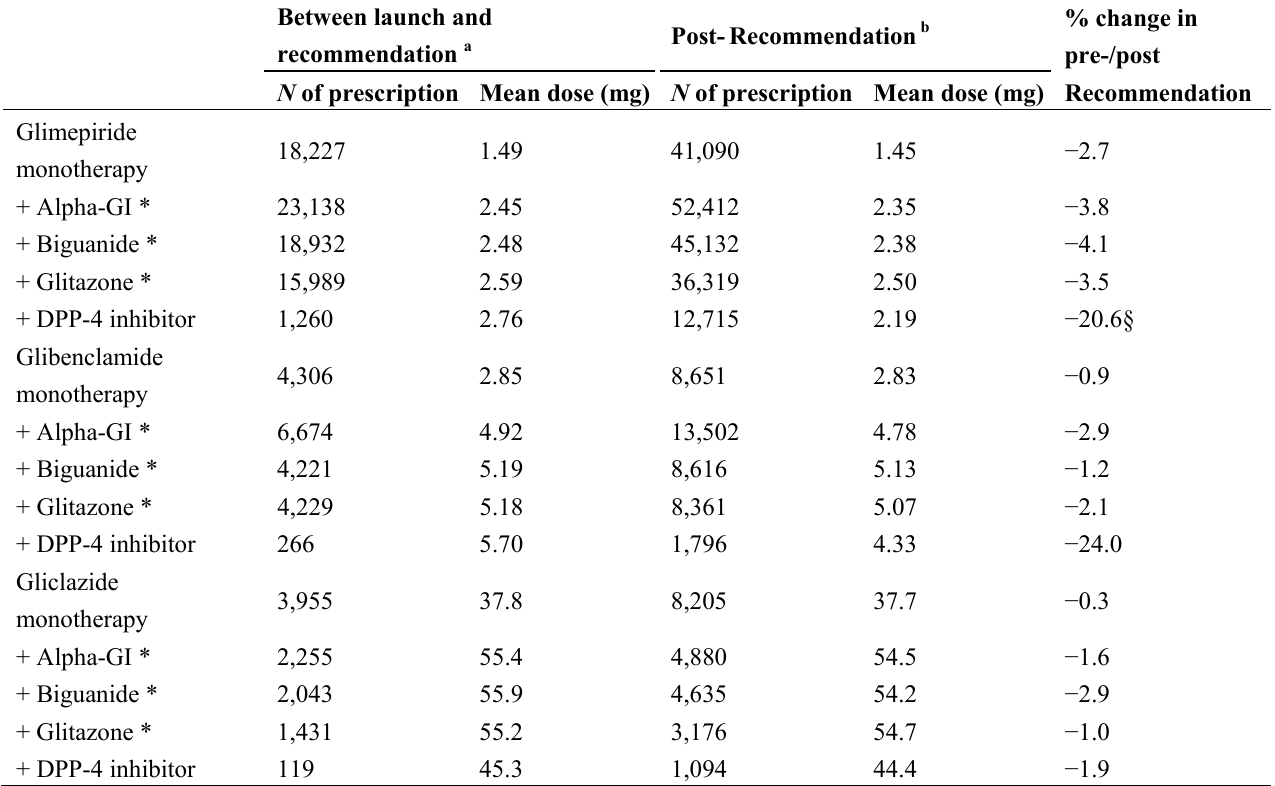
Table 3. Change in SU dose before and after the DPP-4 inhibitor launch and before and after the Japan Association for Diabetes Education and Care (JADEC) recommendation release by type of co-prescribed antidiabetics.